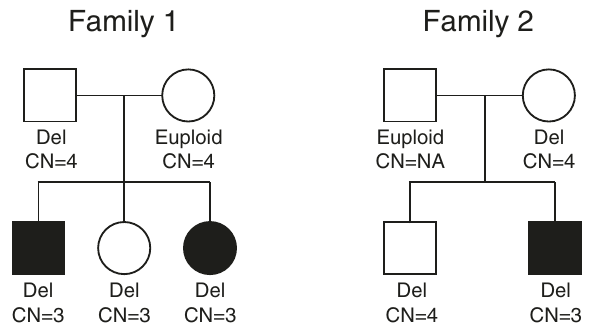
Fig. 2 Pedigrees of two families with 16p11.2 deletion and neutropenia and low lymphocyte counts. The status for the 16p11.2 BP4-BP5 region ( “ Del ” for deletion or “ Euploid ” ) and the copy number (CN) of the BOLA2 duplicon are shown. Filled symbols show members with low neutrophil and lymphocyte Table 1. Genetic and clinical information of two families with 16p11.2 deletion and neutropenia/lymphopenia. Family Individual Gender 16p11.2 CNV status